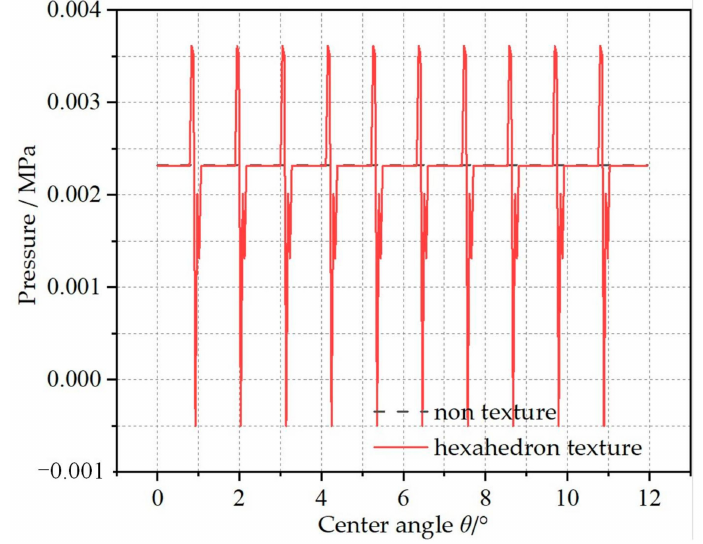
Figure 10. Effect of texture on pressure at outer